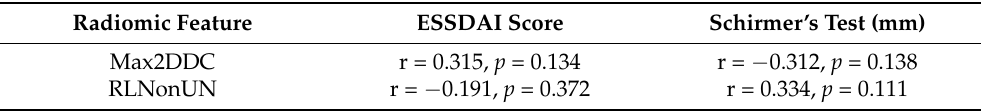
Table 5. Correlation between the two predictive radiomic features for pSS parenchymal changes in LG and the ESSDAI score and Schirmer test values.